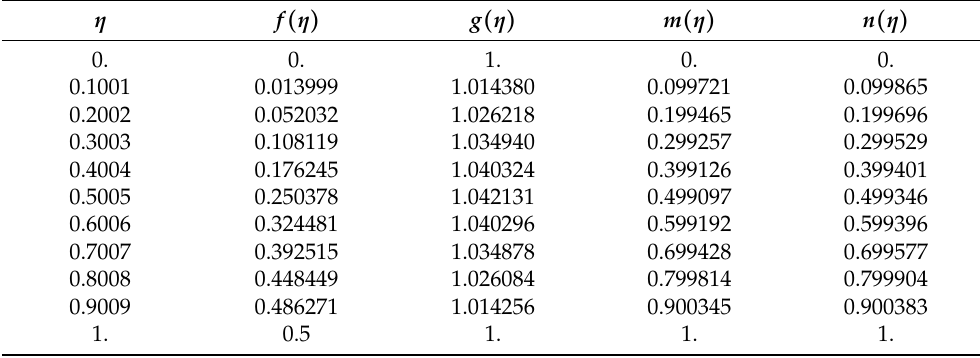
Table 3. Estimated values for f ( η ) , g ( η ) , m ( η ) , and n ( η ) , by fixing S z = − 0.1, M x = 0.1, M y = 0.3, R m = 0.01, S = 1, and different values of η .